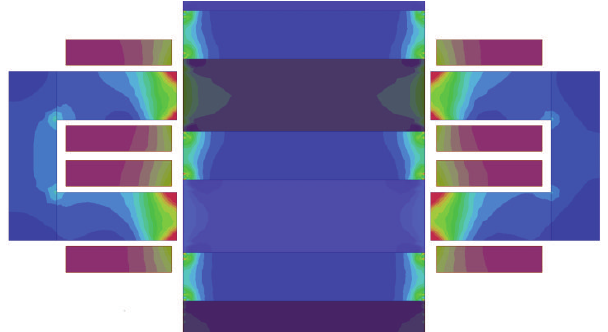
Figure 23: Terminal voltage and current.